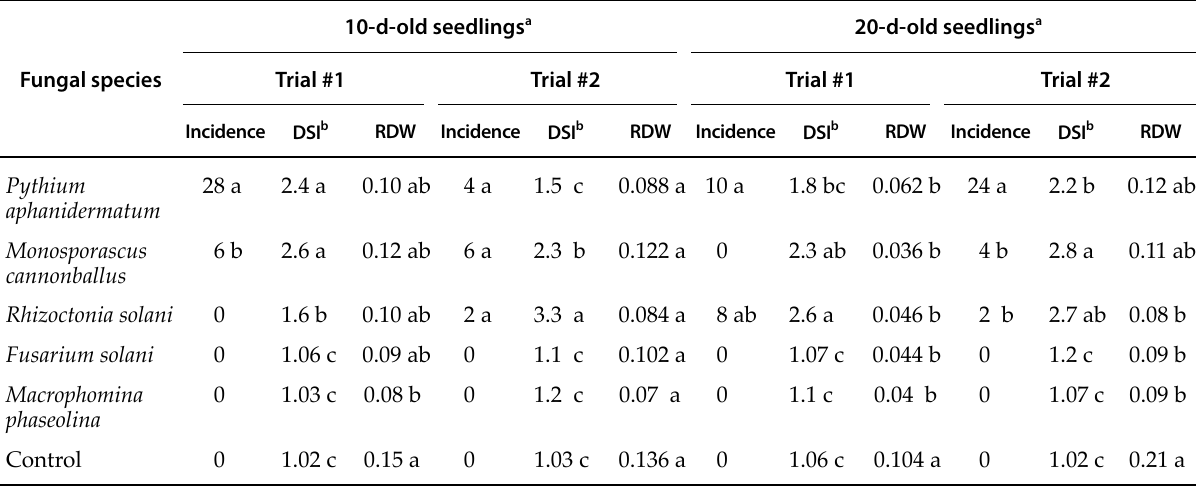
Table 3. Responses of 10-d and 20-d-old muskmelon seedlings (cv. Palmira F1) 28 days after artificial inoculation with fungi isolated from declining muskmelon